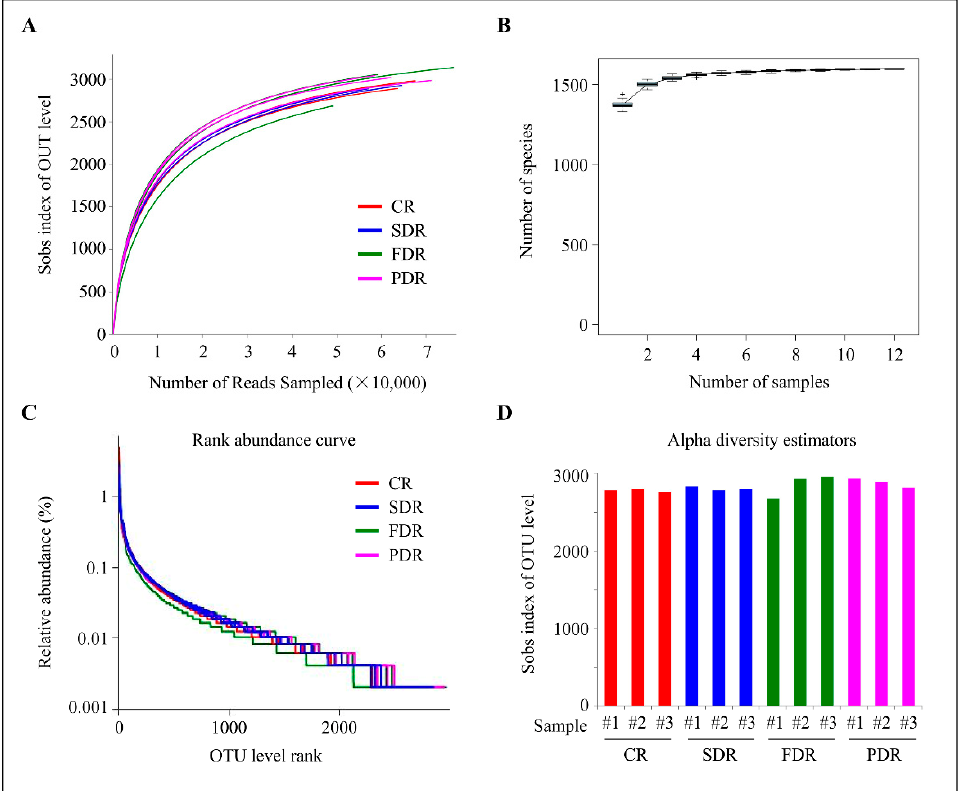
Figure 1. Alpha diversity analysis. ( A ) Rarefaction curve analysis showing the depth of 16S rRNA gene sequencing of peanut rhizosphere and the possibility of observing microbial community diversity. ( B ) Species accumulation curves showing the rate of increase of new species with the increase in sample size. ( C ) Rank abundance curve showing the relative species abundance and evenness. The length of the polyline on the horizontal axis reflects the number of operational taxonomic units (OTUs) in the sample and represents the richness of the microbial community. The flatness of the polyline reflects the evenness of the microbial community composition. ( D ) OTU levels via sobs index analysis showing the relative species abundance of four soil groups in peanut rhizosphere. #1, #2 and #3 represent three duplicate samples in per soil group.